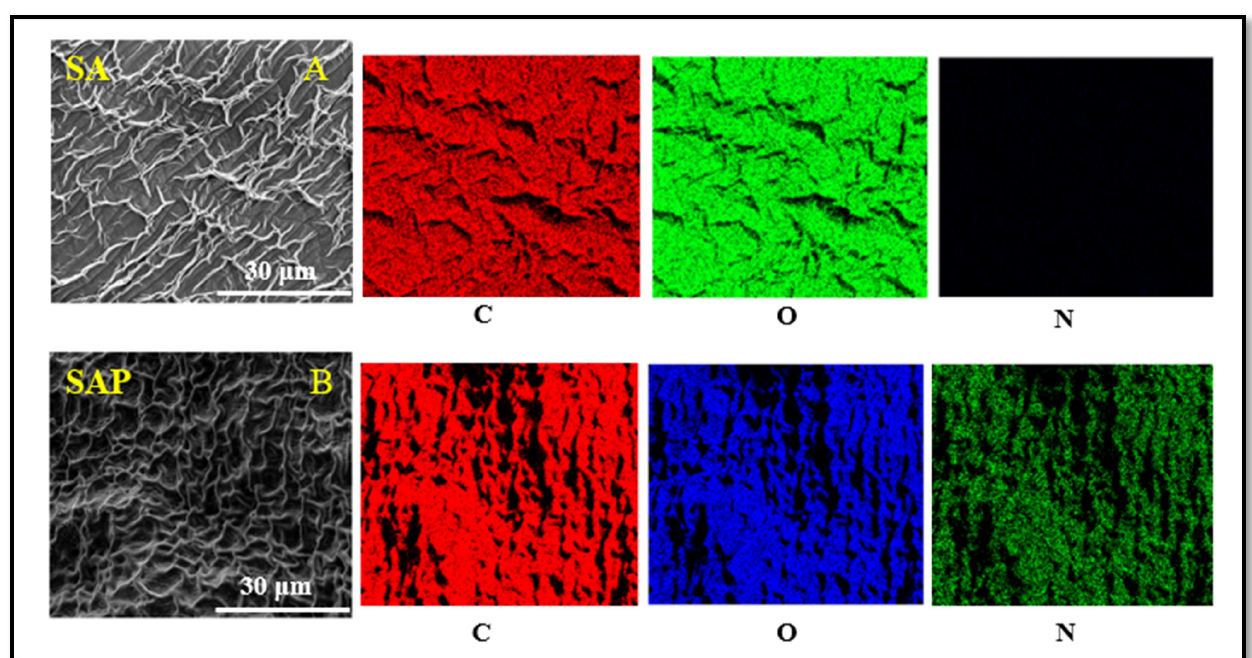
Figure 5. EDX mapping of carbon, oxygen, and nitrogen of sodium alginate hydrogel (SA) and of sodium alginate hydrogel modified with polyethyleneimine (SAP). The micrographs show the effective modification of the SA alginate hydrogel with PEI as shown with the significant increase of the nitrogen element in the EDX mapping. Furthermore, Figure 6 illustrates the difference in the nitrogen distribution peaks between the EDX spectra of SA and SAP. As expected, a new nitrogen peak arises in SAP because of the imine functionalities, but it is missing in SA.